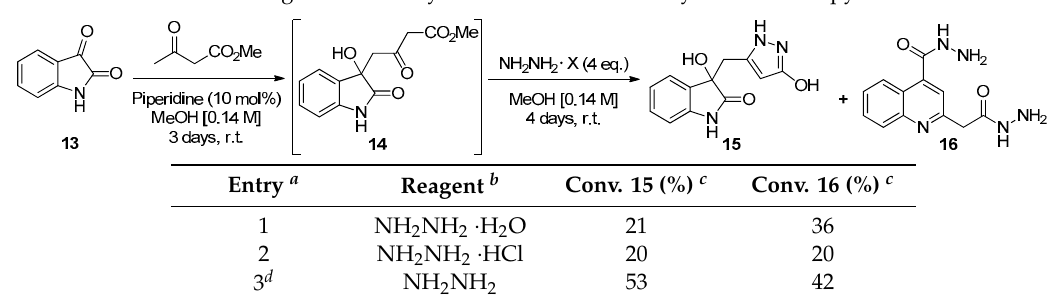
Table 2. Screening of different hydrazine sources for the synthesis of the pyrazole 15 .